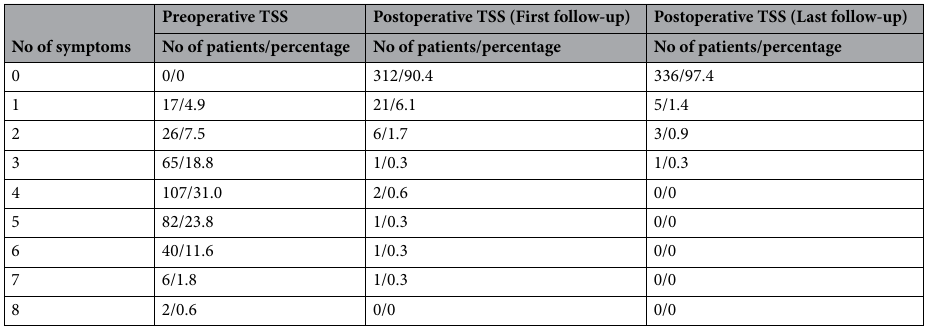
Table 3. Distribution of the TSS among our patients preoperatively and at first and last follow-up visits. TSS total symptoms